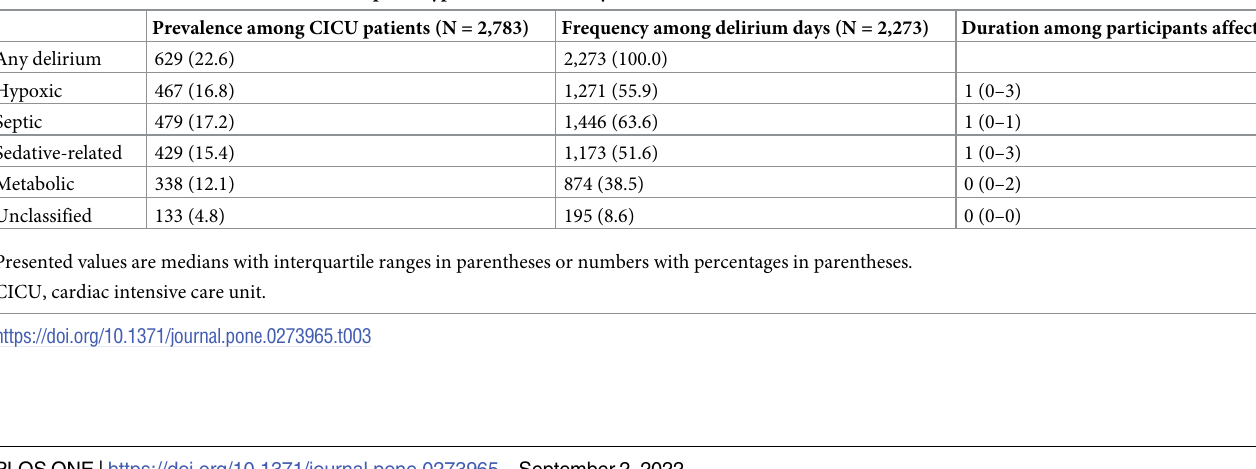
Table 3. Prevalence and duration of delirium phenotypes within seven days of CICU admission. Prevalence among CICU patients (N = 2,783) Frequency among delirium days (N = 2,273) Duration among participants affected, day 2,273 (100.0)